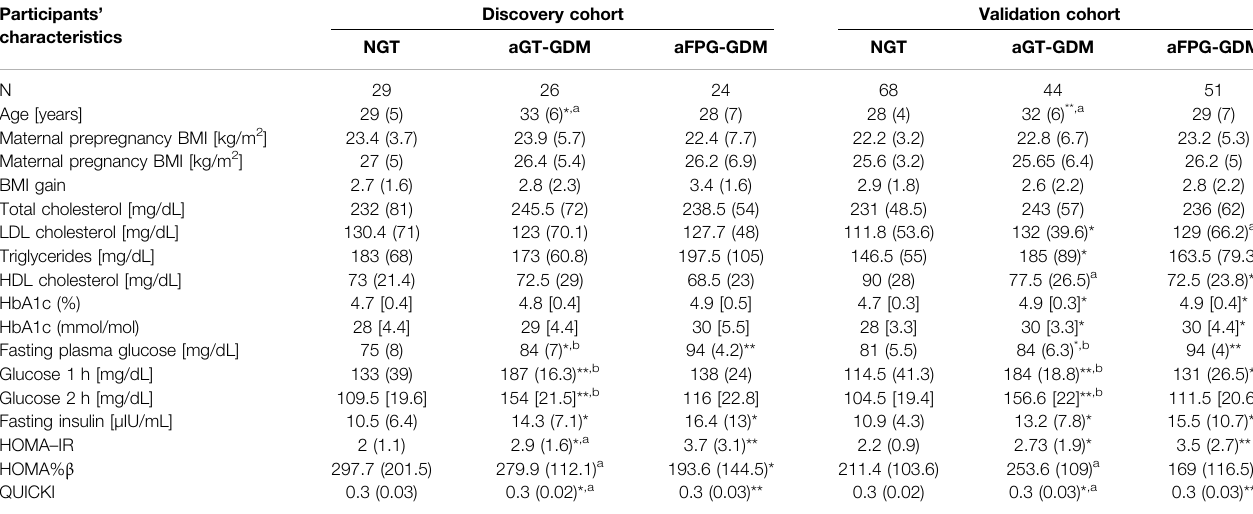
TABLE 1 | Anthropometric and metabolic characteristics of the subgroups – discovery and validation cohort – second trimester (24 – 28 weeks of gestation). Participants ’